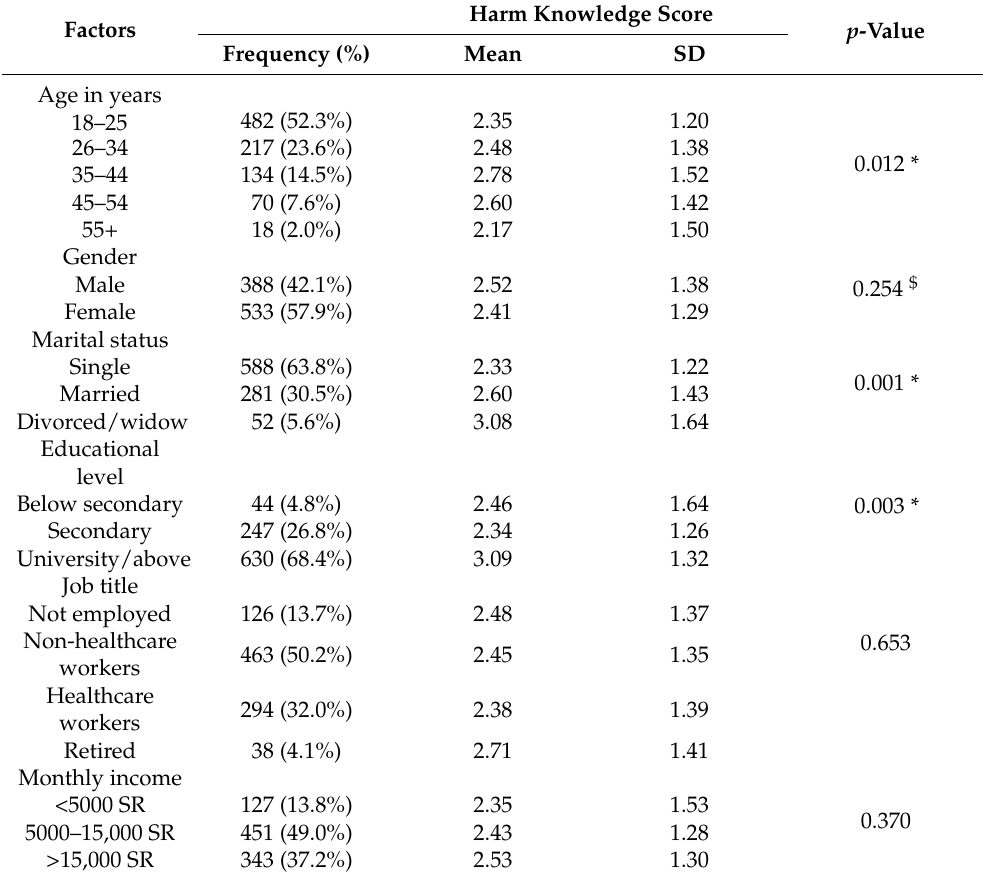
Table 1. Background characteristics and distribution of participants’ knowledge regarding potential harms of foods sold by the family producer-owned food trucks ( n =